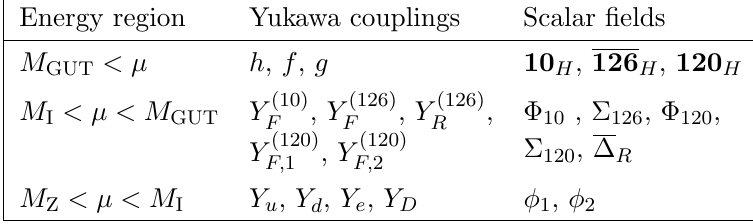
Table 1 . Summary of relevant Yukawa couplings and scalar (cid:12)elds in each energy